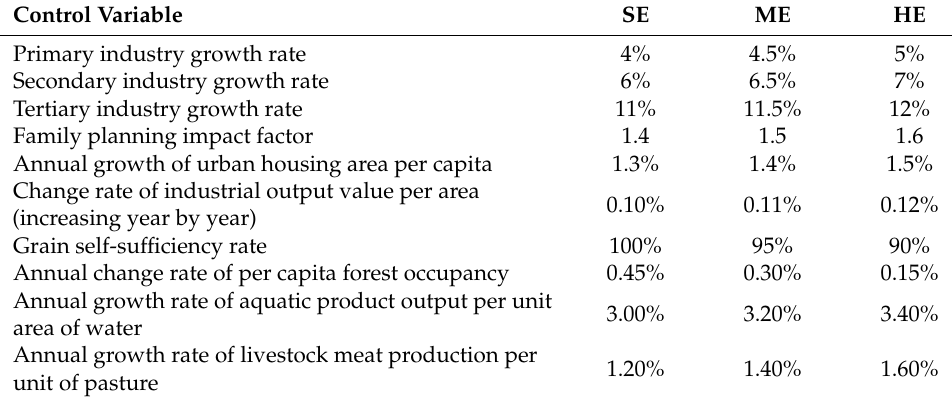
Table 3. Parameters of three